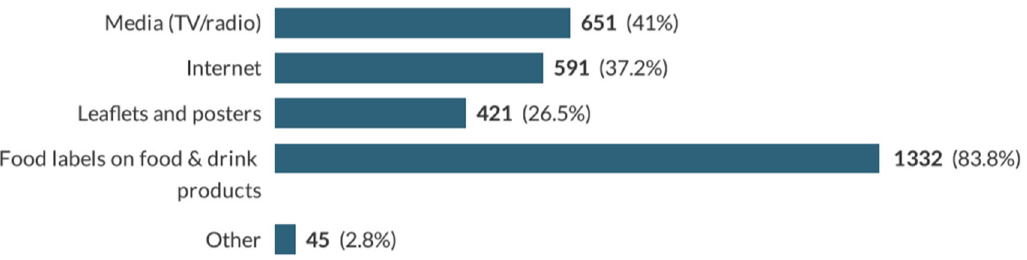
Figure 5. Preferred sources of information for dissemination of safety and benefits of NNS. Other responses included newspapers, schools, and health professionals (doctors, nurses).